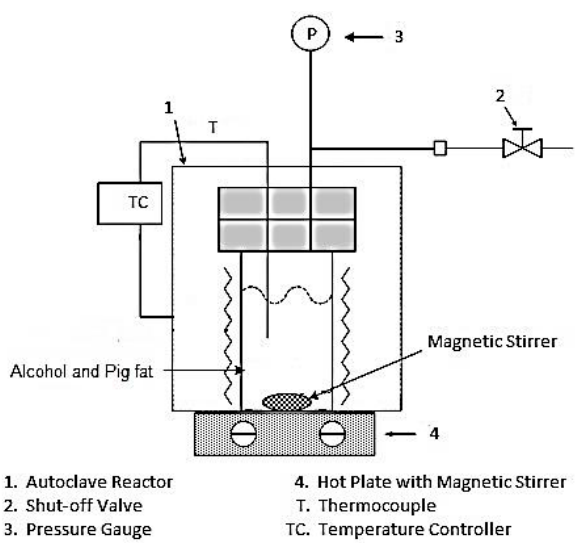
Figure 1. Schematic diagram of the experimental apparatus. Table 2. Operation conditions of GC/MS (Agilent GC with MSD detector) analysis used in this